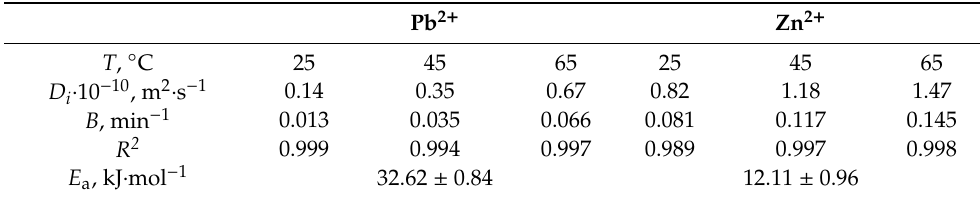
Table 4. Kinetic parameters of The intraparticle di ff usion model for Pb 2 + and Zn 2 + ion sorption at di ff erent temperatures on titanium phosphate (the initial concentration of Pb 2 + and Zn 2 + was 10 mM · L − 1 ).